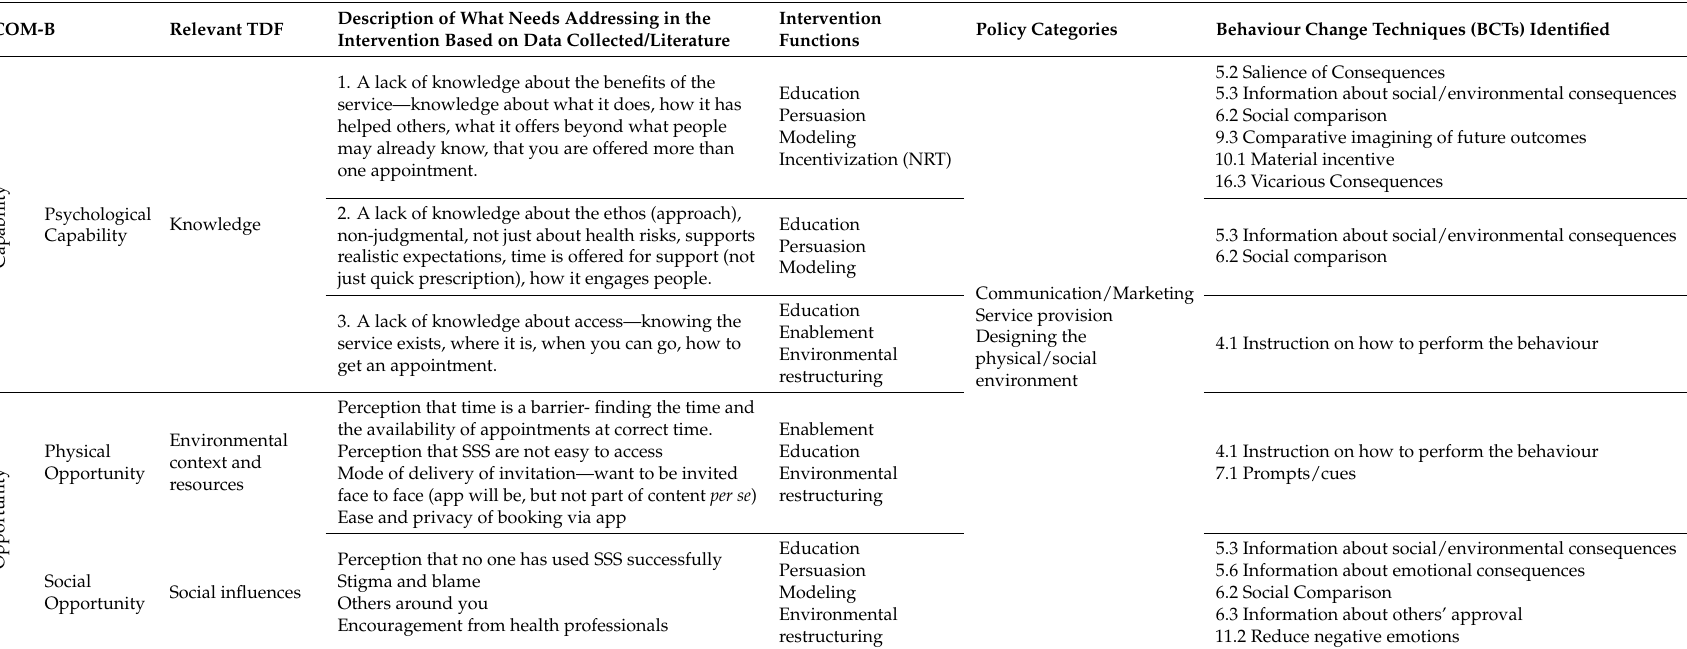
Table 2. Examples of how the findings from the behavioural analysis mapped onto the Behaviour Change